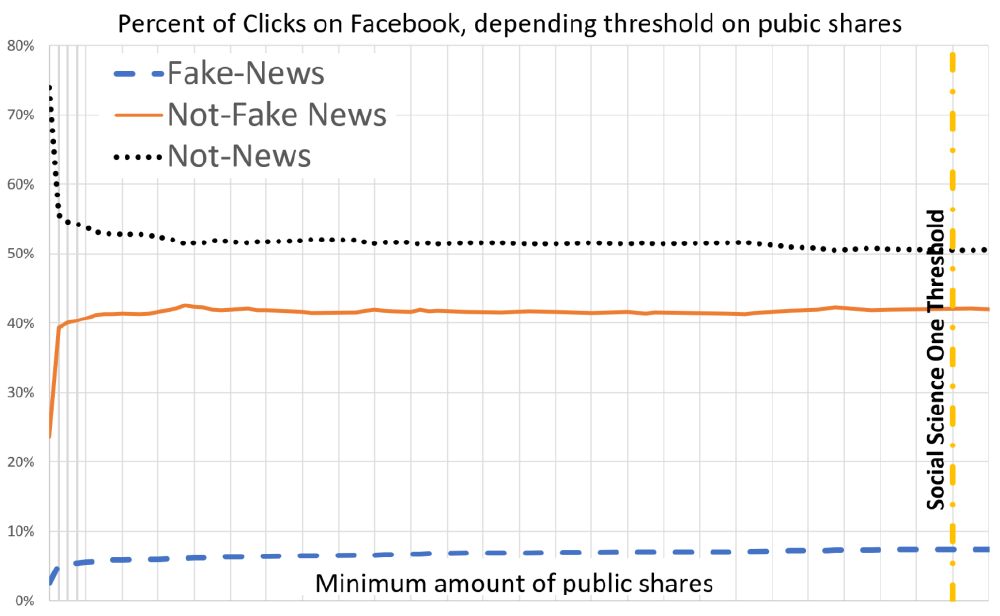
Figure 2. Estimated percentage of clicks on Facebook for fake news, not-fake news, and not-news using the Nielsen data, as threshold moves from 0 to 100 CrowdTangle public shares. Note that CrowdTangle public shares only include shares by public pages and profiles, a more restrictive definition than Facebook